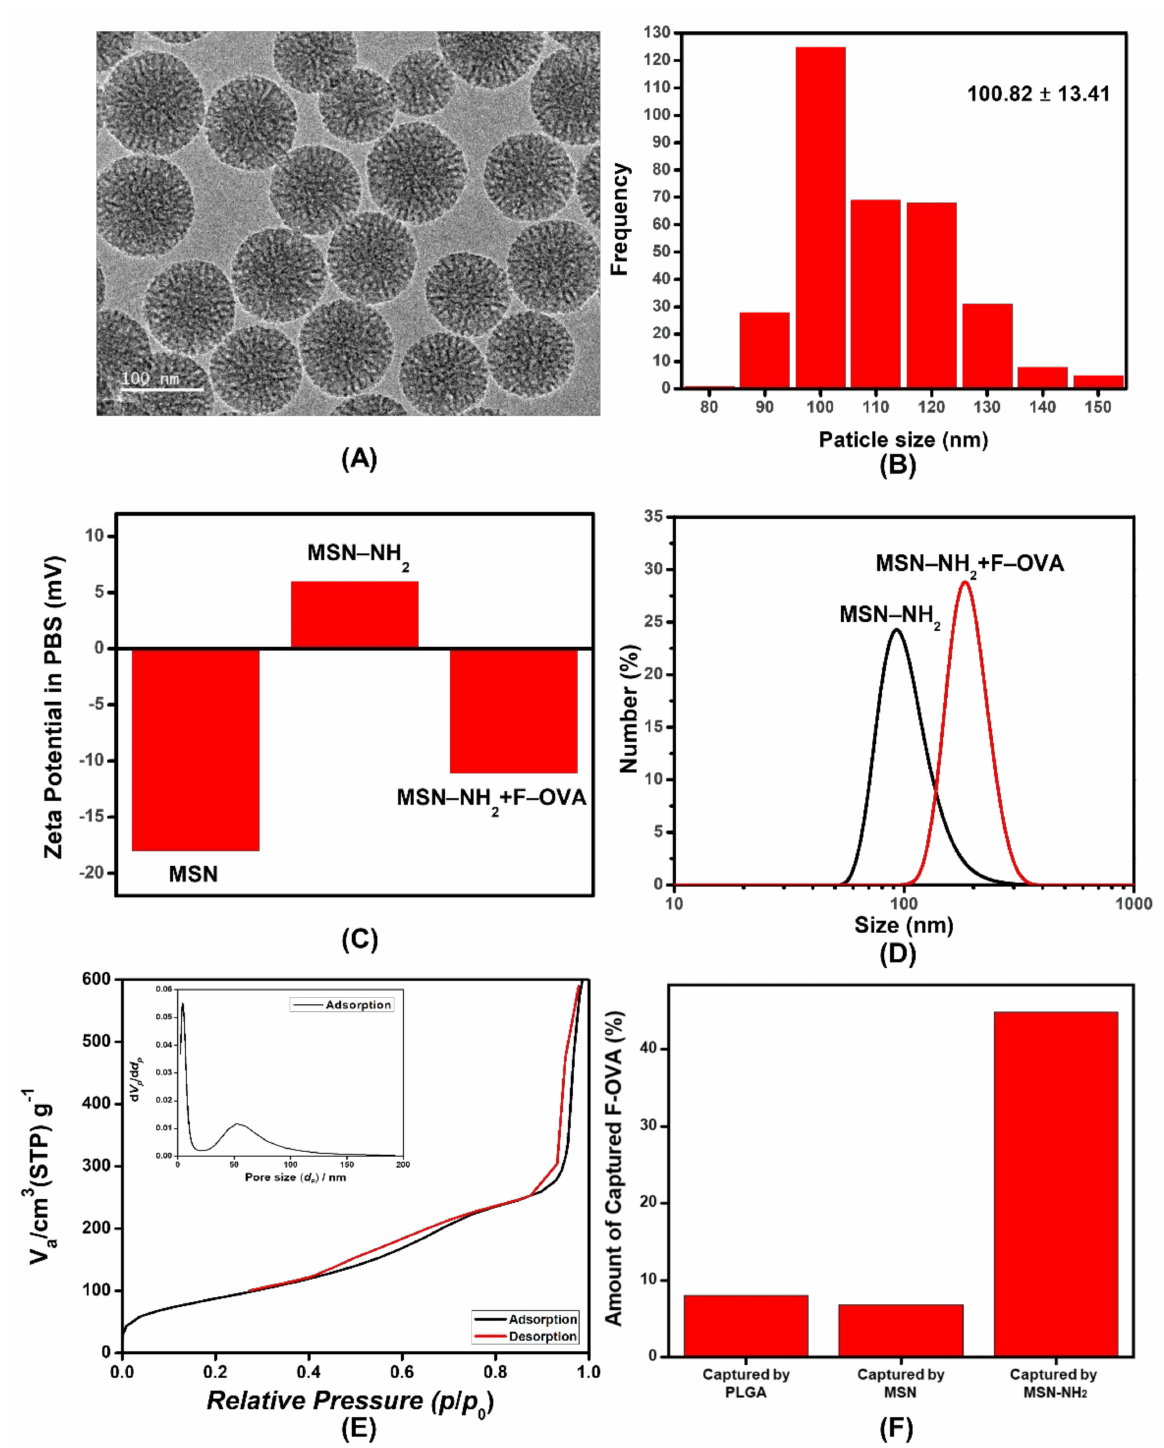
Figure 1. Synthesis of mesoporous silica nanoparticles (MSNs) with antigen-capturing capacity. ( A ) Transmission electron microscopy image of MSNs and ( B ) diagraph showing size distribution. ( C ) Zeta potentials of MSN, MSN-NH 2 and MSN-NH 2 after capturing fluorescein-conjugated ovalbumin (F-OVA). ( D ) Hydrodynamic diameter of MSN-NH 2 before and after capturing F-OVA. ( E ) N 2 absorption/desorption isotherms of MSNs. (Inset: pore size distribution from the adsorption branch). ( F ) Amount of F-OVA captured by poly-lactic- co -glycolic acid (PLGA), MSNs and MSN-NH 2